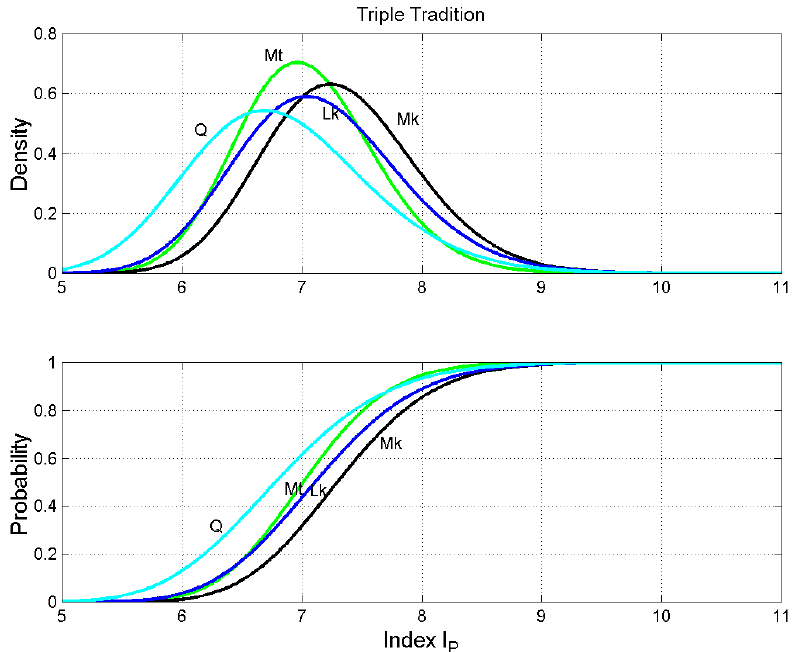
Figure 8. Triple Tradition and Q. Probability density functions (upper panel) and probability distribution functions (lower panel) of the number of words per interpunctions (word interval) 𝐼 𝑃 . Matthew : green line; Mark: black line; Luke : blue line; Q : cyan line.